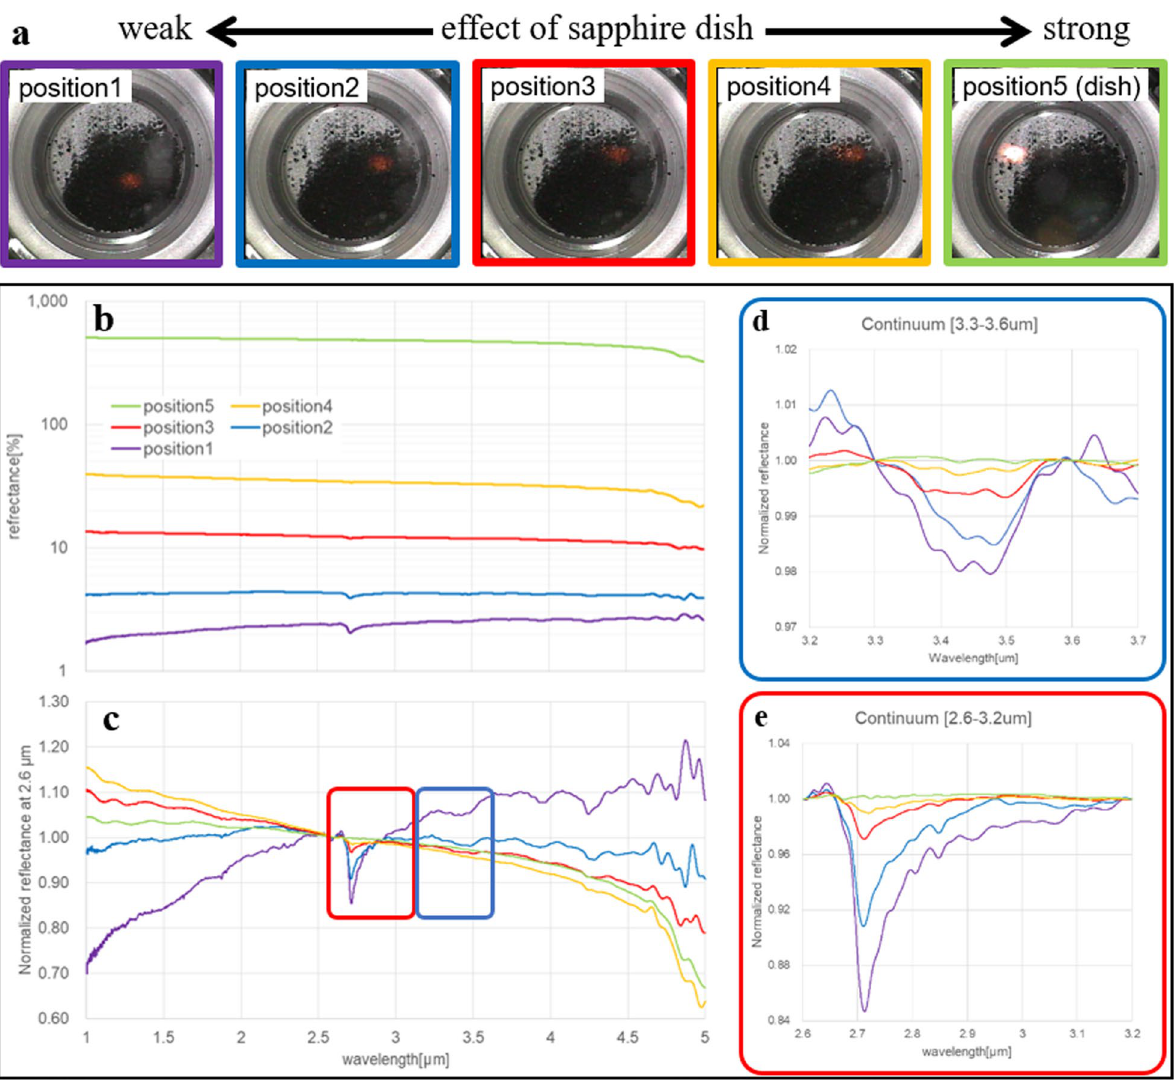
Fig. 4 Effect of reflectance from sapphire dish. a Measurement areas on the aggregate sample, A9009. Grains and particles are fully occupied in the beam spot in position 1. Measurement spots were then shifted to the edge of the aggregate sample and void ratio increases from positon 2 to 4. Sapphire dish itself is measured in position 5. b Reflectance spectra of each measurement area increasing from positions 1 to 5. c Reflectance spectra normalized at 2.6 μm to compare the spectral profiles of positions 1 to 5. d Normalized reflectance spectra continuum with 2.6–3.2 μm, and e 3.3–3.6 μm show the change in absorption band depth from positions 1 to